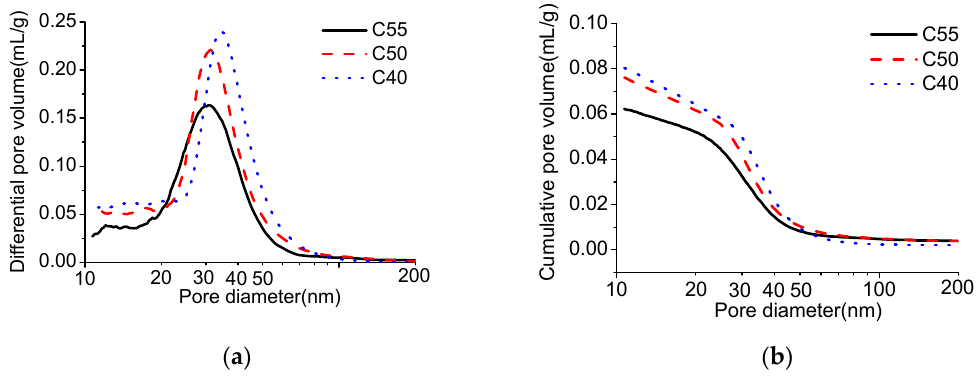
Figure 5. Mercury intrusion porosimetry (MIP) results of C40, C50, and C55. ( a ) Differential pore volume. ( b ) Cumulative pore volume.